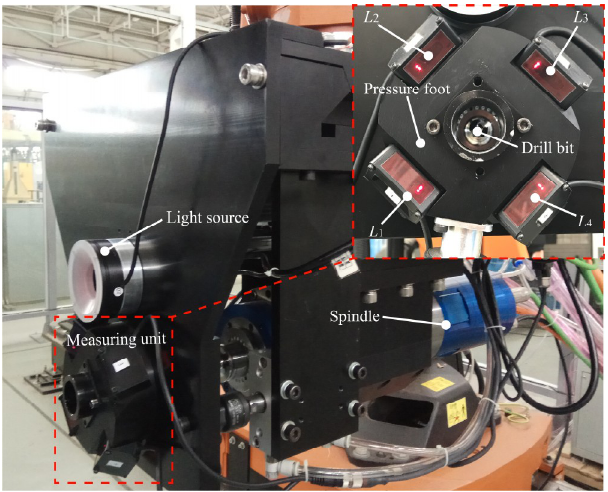
Figure 3. The installation of four laser displacement sensors.